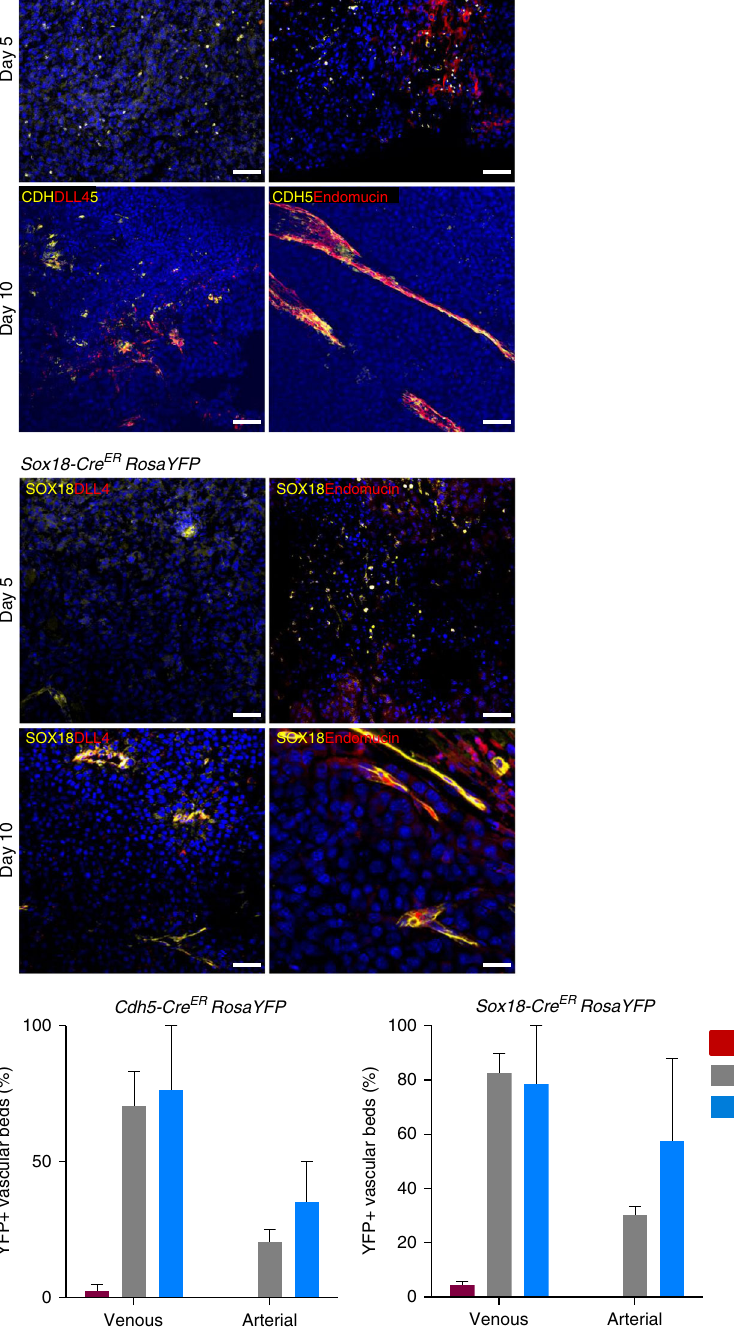
Fig. 3 EVP contribution to arterial and venous beds. Representative micrographs of tumor sections taken from Cdh5-Cre ER RosaYFP and Sox18-Cre ER RosaYFP lineage tracing models. At day 5 YFP + cells did not display any arterial or venous markers. By day 10 and 15 YFP + cells could be co-localized with arterial marker DLL4 and venous marker endomucin ( n = 5). Results presented as mean ± SEM. Scale bar represents 150 μ